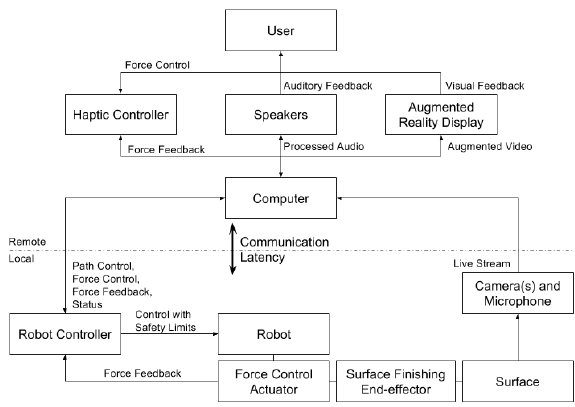
Figure 1: Diagram of a telerobotic surface finishing system